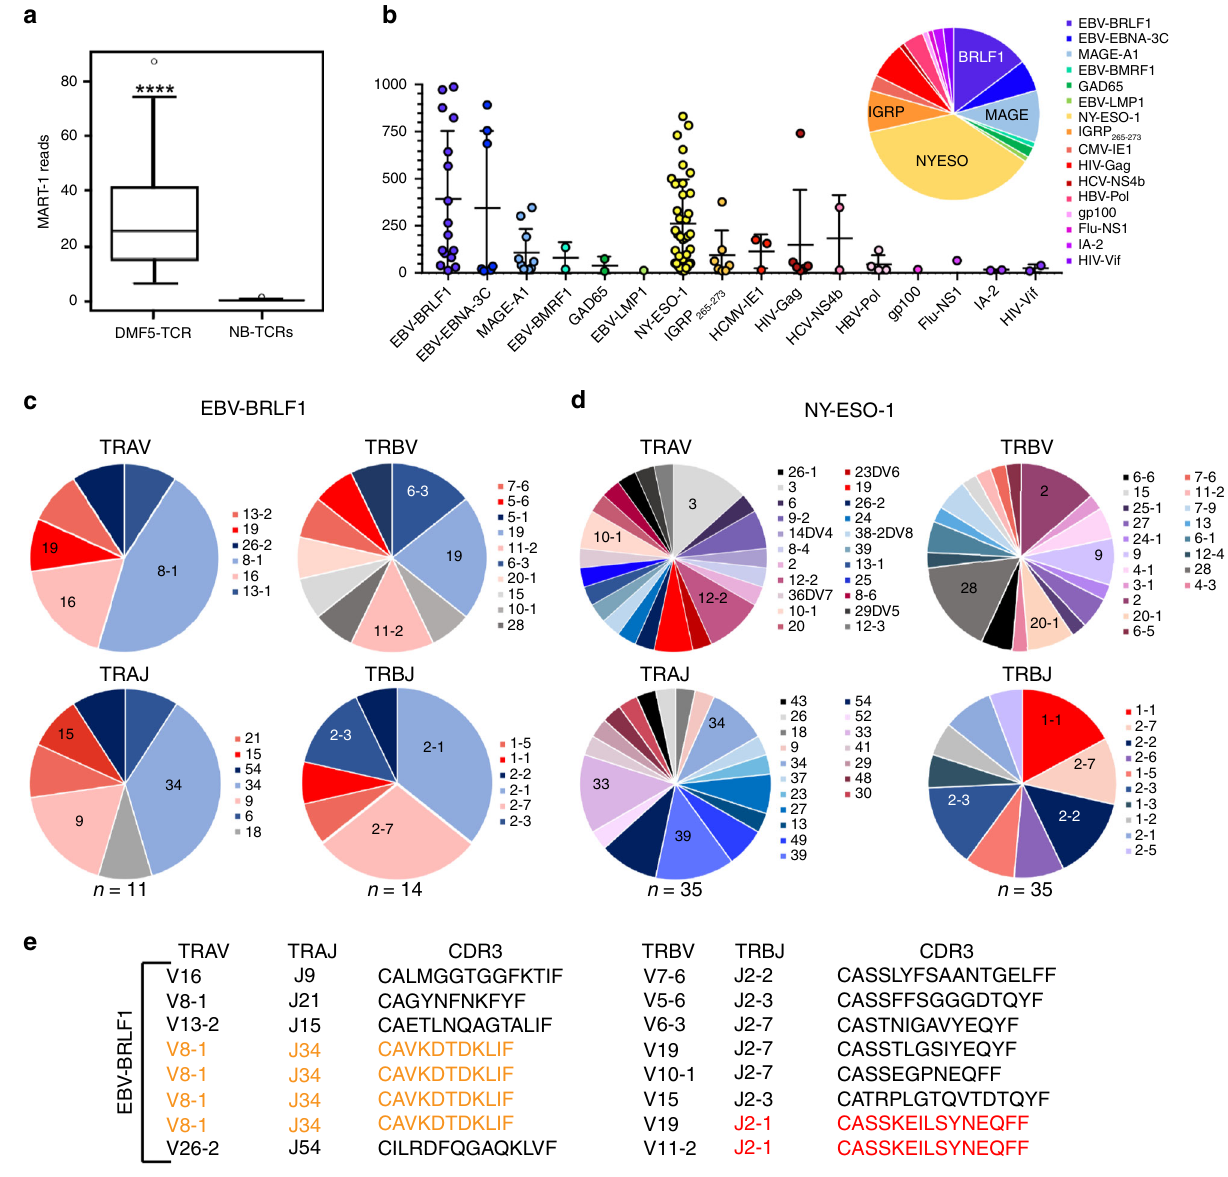
Fig. 7 Identi fi cation of paired αβ TCR sequences with their antigen speci fi cities. a Recovery of MART-1 tetramer barcodes on DMF5 cells from PBMC- DC co-cultures spiked with 1% DMF5 cells. Number of MART-1 tetramer reads among DMF5 positive (DMF5-TCR) and negative (NB-TCR) cells. Cells are classi fi ed as positive/negative according to sequencing reads of the DMF5 TCR, where >10 DMF5 reads was used as a cutoff to classify DMF5 + cells. Box graphs display the distribution of MART-1 tetramer reads from DMF5 + (>10 DMF5 reads n = 76) and DMF5- ( ≤ 10 DMF5 reads, n = 927) cells. Upper/ lower bars and box boundaries indicate the 95th/5th and 75th/25th percentiles, respectively, horizontal box lines indicate medians. Statistical signi fi cance was assessed using a two-tailed Mann-Whitney test ( p -value < 0.0001). b Distribution of antigen speci fi cities identi fi ed from tetramer + /CD8 + T cells from human splenocytes and the number of tetramer-barcode read per cell. Each dot represents a single cell, n = 102 in total, error bars correspond to one standard deviation from the mean. c , d V(D)J usage of cells identi fi ed as speci fi c for the EBV-BRLF1 (YVLDHLIVV) and NY-ESO-1 (SLLMWITQA) antigens. All TRAVJ ( n = 11/35) and TRBVJ ( n = 14/35) chains identi fi ed are represented. e TCR CDR3 sequences identi fi ed for antigen-speci fi c T cells. Consensus BRLF-1 TRA and NY-ESO-1 TRB chains are highlighted in orange and red, respectively. Gating strategies used for sorting tetramer + cells are outlined in Supplementary Fig. 11. Source data are provided as a Source Data fi